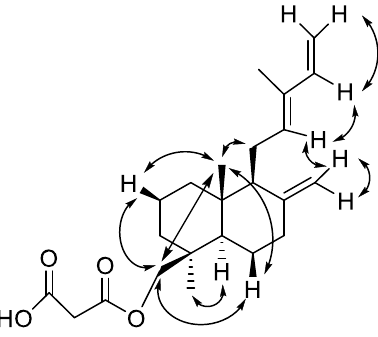
Figure 2. Key NOESY interactions observed for compound 1 .